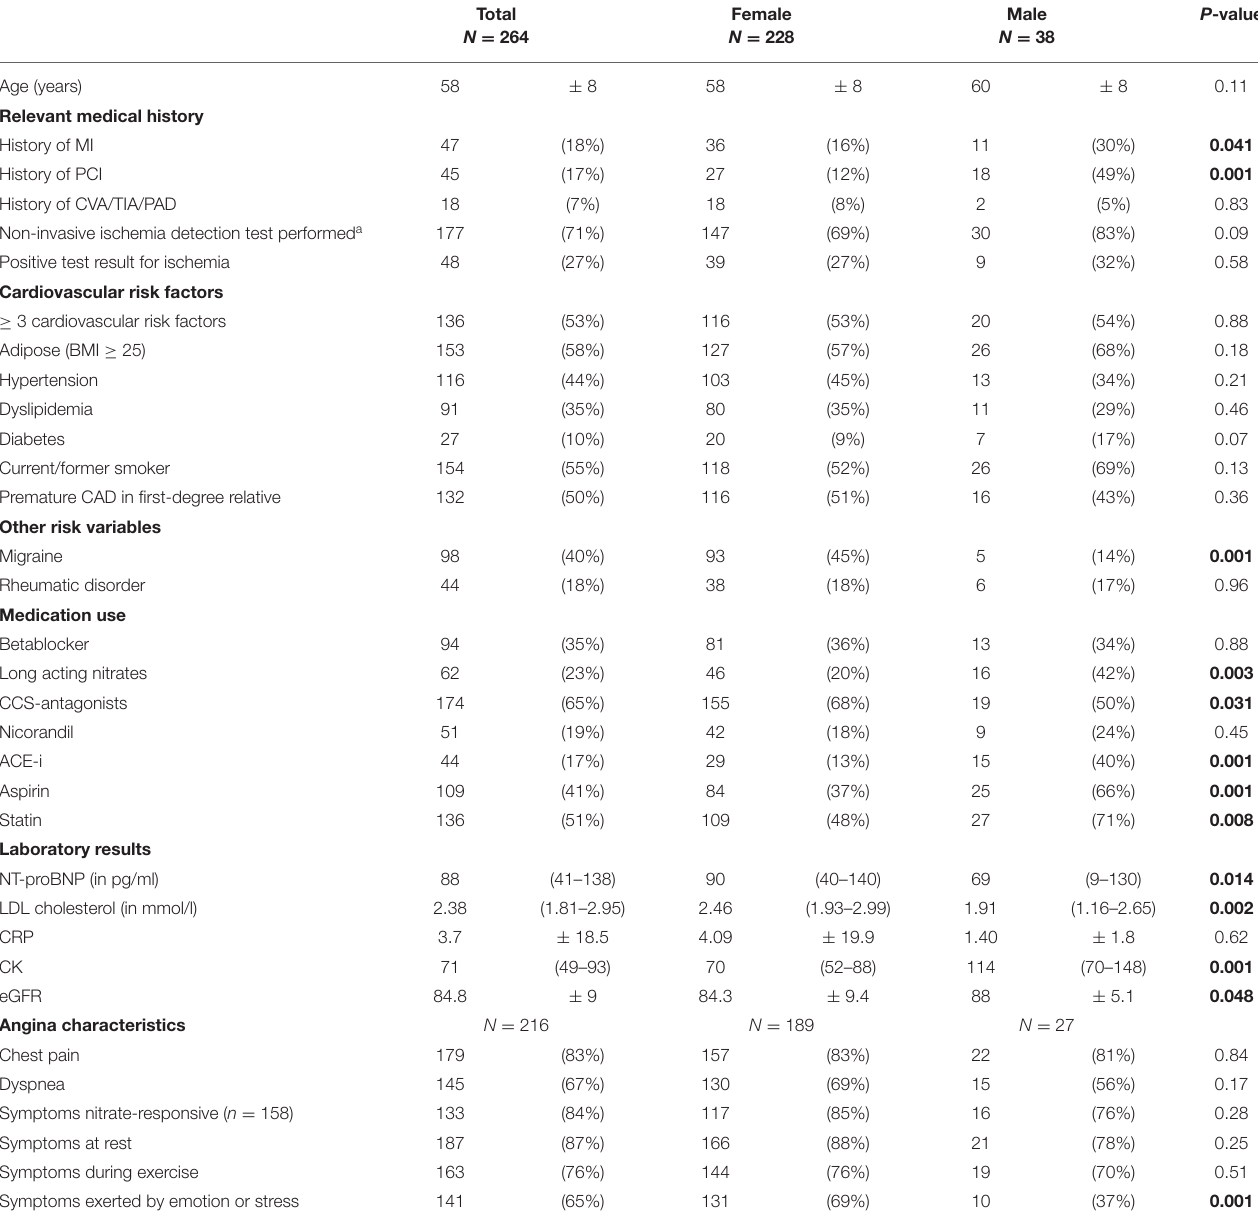
TABLE 1 | Patient characteristics of patients undergoing coronary function testing according to